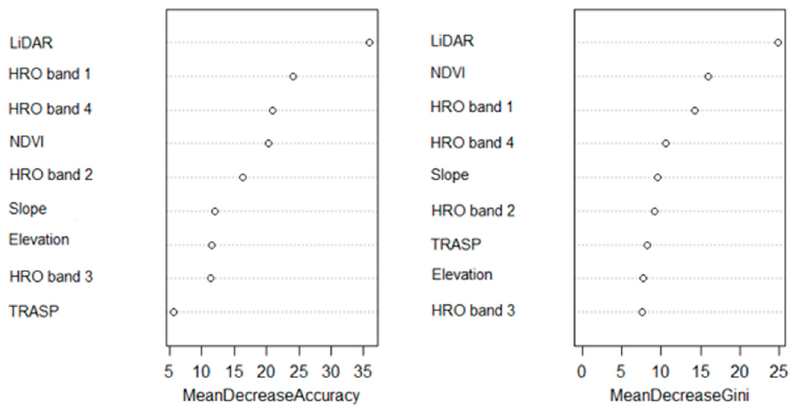
Figure 7. Mean decrease for variable importance and Gini impurity for the Anderson fire behavior fuel model [32] map product at Army Garrison Camp Williams. LiDAR = height of vegetation from light detection and ranging values determined by taking first return values minus bare earth values, HRO band 1–4 = high resolution orthoimagery taken from band 1–4, respectively. NDVI = normalized difference vegetation index, and TRASP = transformed aspect.